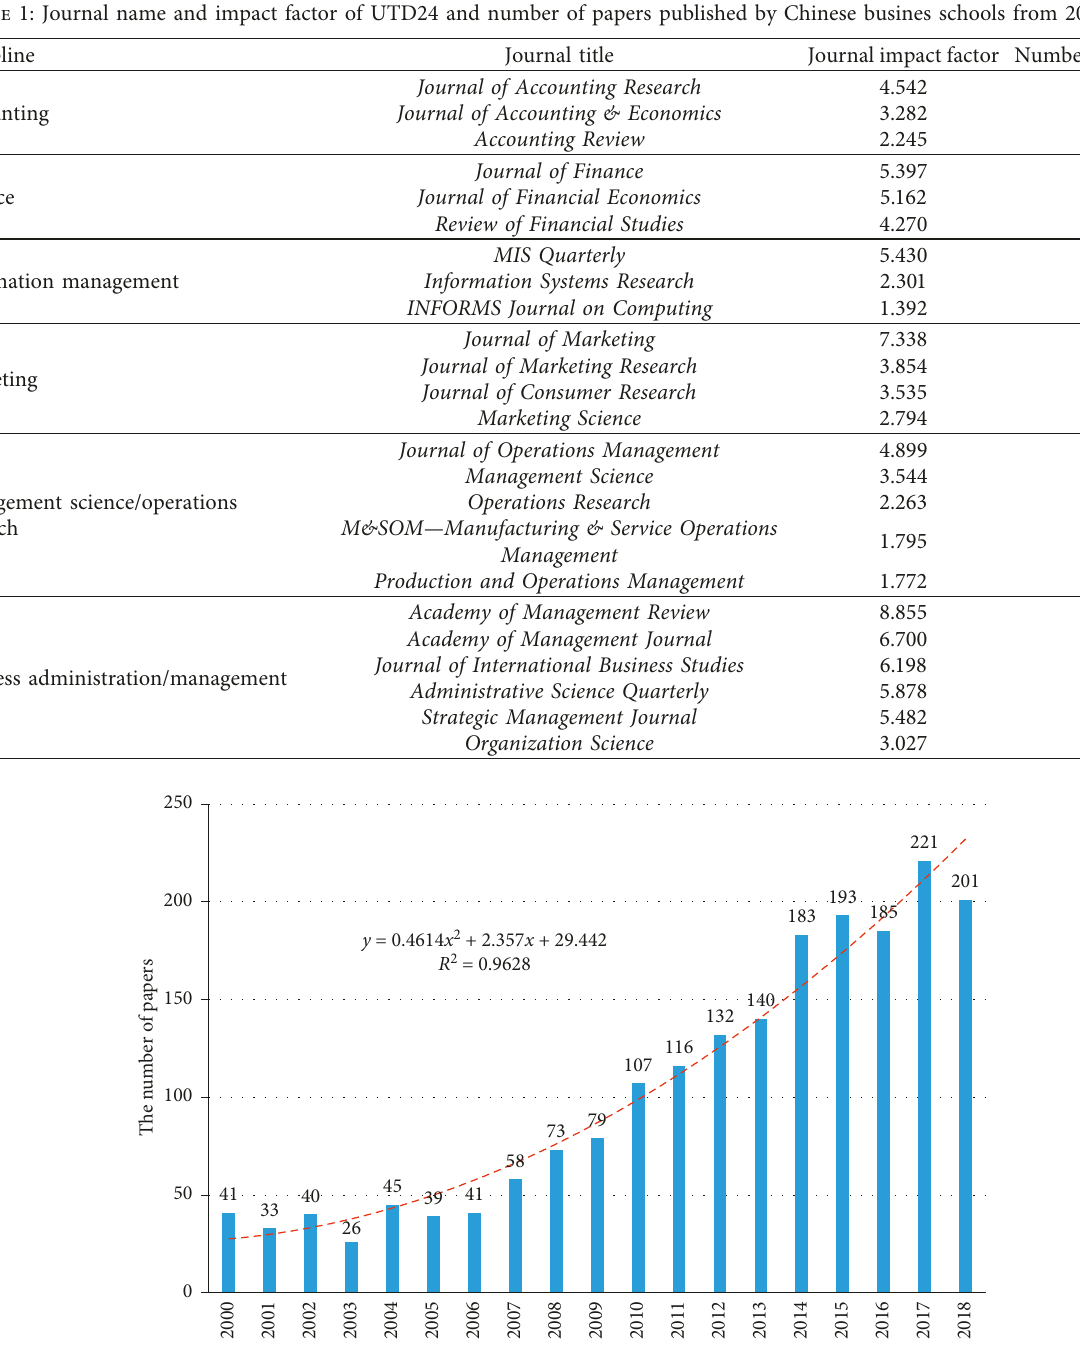
Figure 1: Number of papers published by Chinese business school on UTD24 from